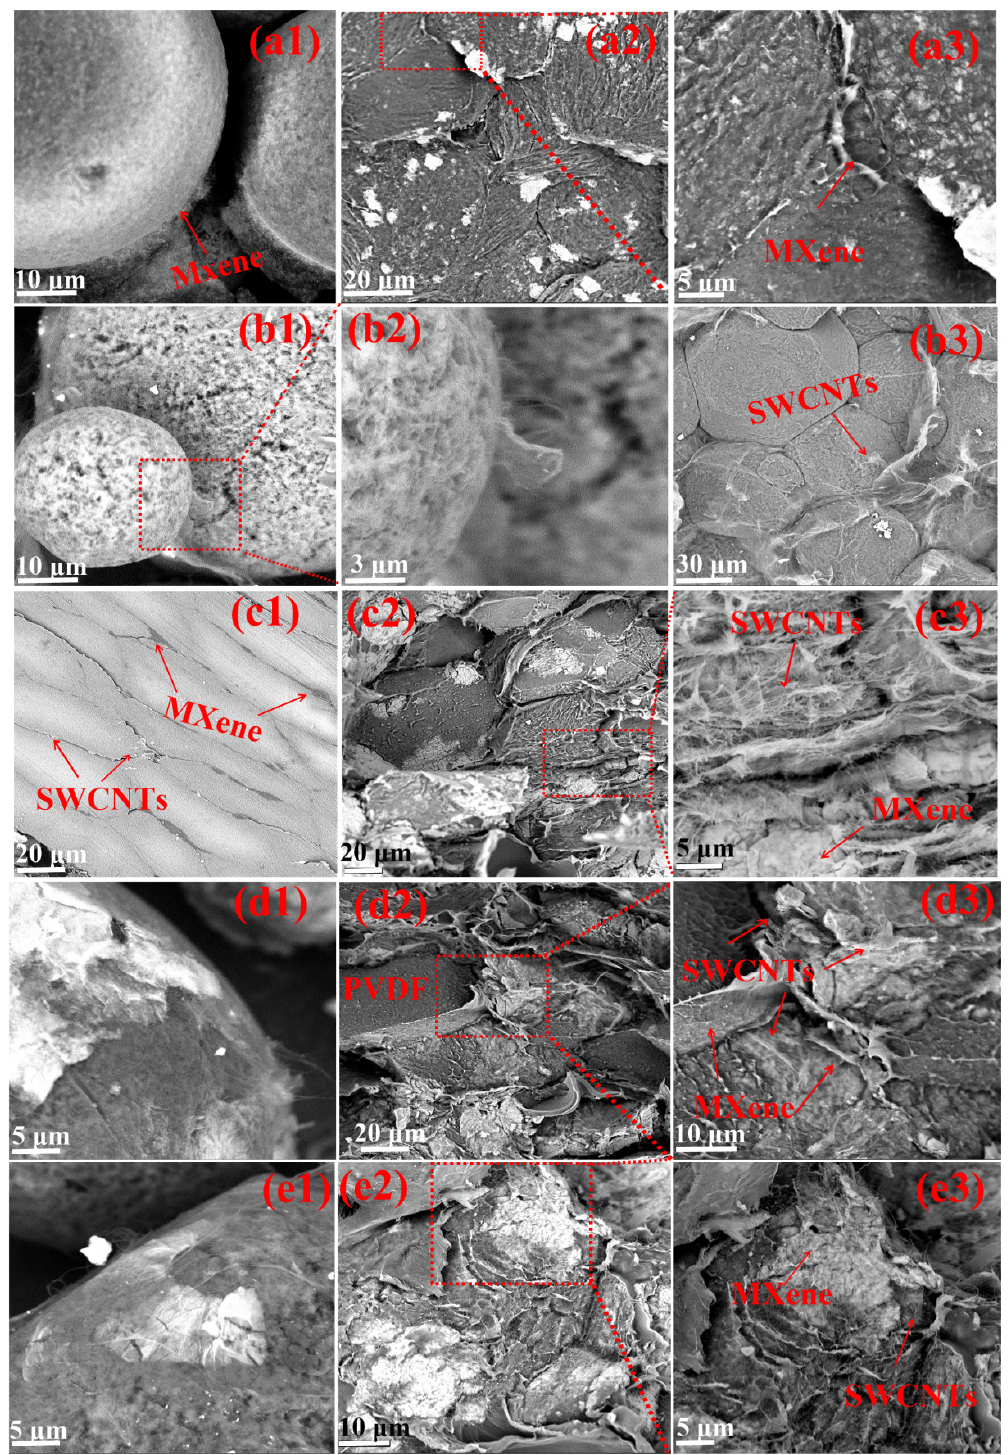
Figure 3. Morphology ( a1 ) of PVDF/MXene5 microspheres; cross-sectional morphology ( a2 ) and magnified view ( a3 ) of PVDF/MXene composite. SEM ( b1 ) and enlarged view ( b2 ) of PVDF/SWCNTs2 microspheres; ( b3 ) Cross-sectional morphology of PVDF/SWCNTs composite; ( c1 ) cutting morphology, ( c2 ) cross-sectional morphology, and ( c3 ) the enlarged view of PVDF/MXene2.5/SWCNTs1. ( d1 ) Morphology of PVDF-SWCNTs1-MXene2.5 microspheres; ( d2 ) morphology and ( d3 ) the enlarged view of PVDF-SWCNTs1-MXene2.5 composite. Morphology ( e1 ) of PVDF-MXene2.5-SWCNTs1 microspheres; morphology ( e2 ) and the enlarged view ( e3 ) of PVDF- MXene2.5-SWCNTs1 composite.